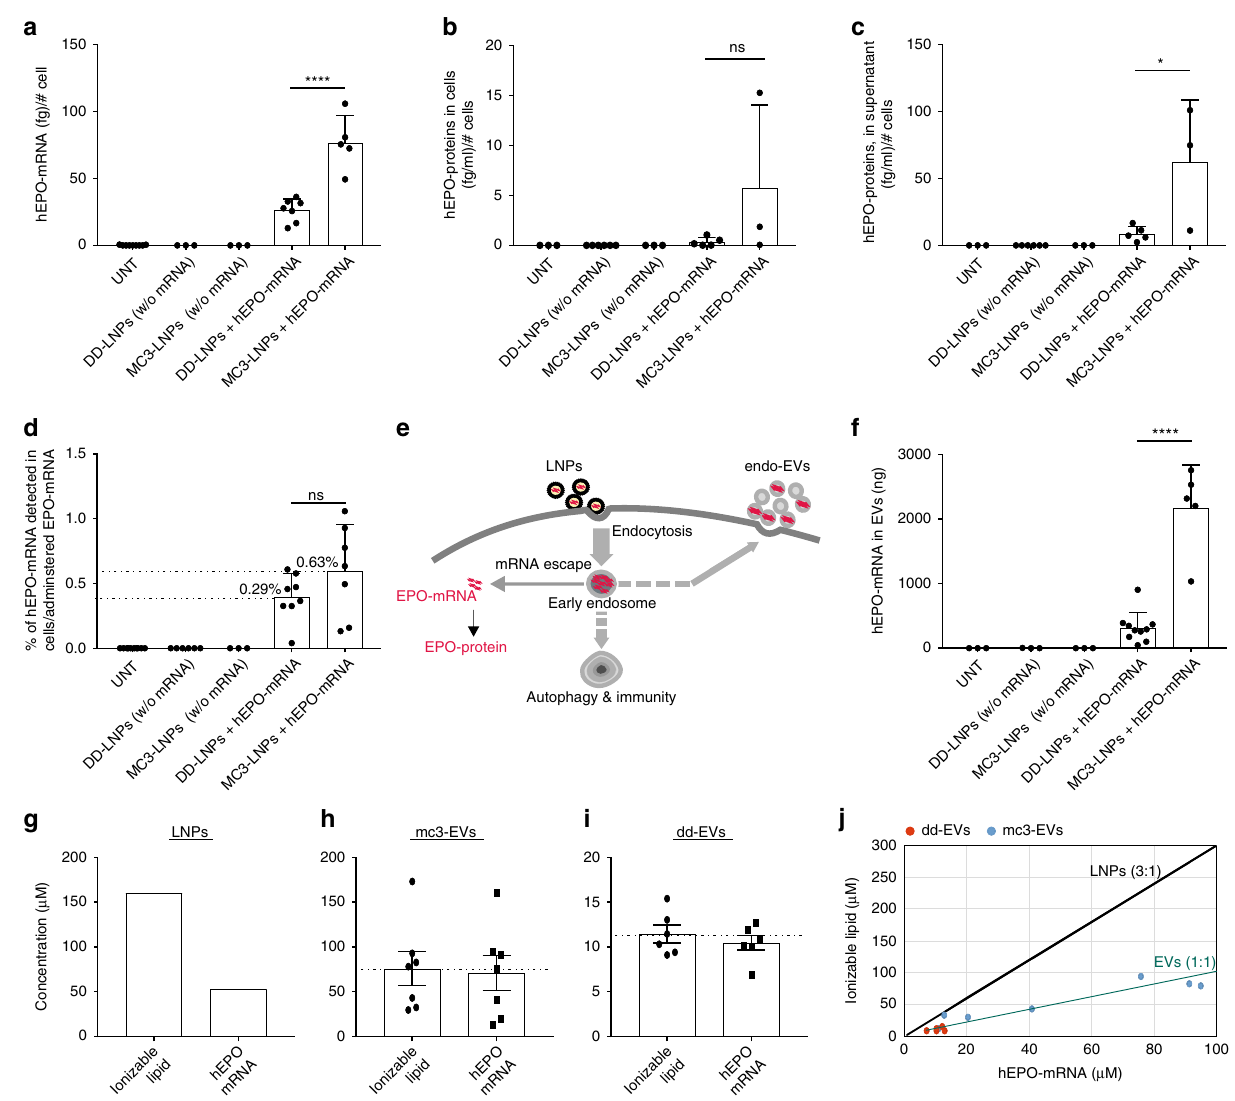
Fig. 1 Delivery of hEPO mRNA to cells via LNPs and analysis of endo-EVs. MC3-LNPs and DD-LNPs containing 100 μ g of hEPO-mRNA were transferred to human epithelial (HTB-177) cells. Untreated cells and cells treated with empty LNPs (without hEPO mRNA) were used as controls. a Amount of hEPO mRNA detected in cells. Untreated ( n = 9), DD-LNPs (w/o mRNA) ( n = 3), MC3-LNPs (w/o mRNA) ( n = 3), DD-LNPs + mRNA ( n = 7), and MC3- LNPs + mRNA ( n = 5). b Amount of hEPO protein detected in cells. Untreated ( n = 3), DD-LNPs (w/o mRNA) ( n = 6), MC3-LNPs (w/o mRNA) ( n = 3), DD-LNPs + mRNA ( n = 5), and MC3-LNPs + mRNA ( n = 3). c Amount of hEPO protein detected in the supernatant of cultured cells. Untreated ( n = 3), DD-LNPs (w/o mRNA) ( n = 6), MC3-LNPs (w/o mRNA) ( n = 3), DD-LNPs + mRNA ( n = 5), and MC3-LNPs + mRNA ( n = 3). d Percentage of hEPO mRNA detected in the cytosol of cells relative to the total amount of mRNA administered (100 µ g) to cells via LNPs. Untreated ( n = 10), DD-LNPs (w/o mRNA) ( n = 6), MC3-LNPs (w/o mRNA) ( n = 3), DD-LNPs + mRNA ( n = 8), and MC3-LNPs + mRNA ( n = 7). e Hypothetical presentation of the endosomal escape of hEPO mRNA of LNPs into the cytoplasm and translation into protein, versus loading of hEPO mRNA into endo-EVs. f Total amount of hEPO mRNA quanti fi ed in endo-EVs isolated from LNP-treated cells. Untreated ( n = 3), DD-LNPs (w/o mRNA) ( n = 3), MC3-LNPs (w/o mRNA) ( n = 3), DD-LNPs + mRNA ( n = 10), and MC3-LNPs + mRNA ( n = 5). g Molar concentrations of ionizable lipids and hEPO-mRNA (ionizable lipids per hEPO mRNA nucleotides) in originally formulated LNPs (control, n = 1), which contains 3 moles of ionizable lipids per 1 mole of mRNA nucleotides. h Molar concentration of ionizable lipids and hEPO-mRNA of mc3-EVs ( n = 7). i Molar concentration of ionizable lipids and hEPO-mRNA of dd-EVs ( n = 6). j Stoichiometric comparison between LNPs and endo-EVs regarding molar ratio (mole/mole) of ionizable lipids per hEPO-mRNA nucleotides. Red circles (dd-EV) and blue circles (mc3-EV). Ionizable lipids and hEPO-mRNA of mc3-EVs ( n = 7) each. Ionizable lipids and hEPO-mRNA of dd-EVs ( n = 6) each. Data are presented as scatter dot plots including the mean (bars) and standard deviation (SD) of the number ( n ) of biologically independent samples speci fi ed for each panel. MC3-LNP and DD-LNP groups ( a – d , f ) were compared using the unpaired two-tailed Student ’ s t -test. ** p < 0.01, **** p < 0.0001 and ns = not signi fi cant. Source data are provided as a Source Data fi